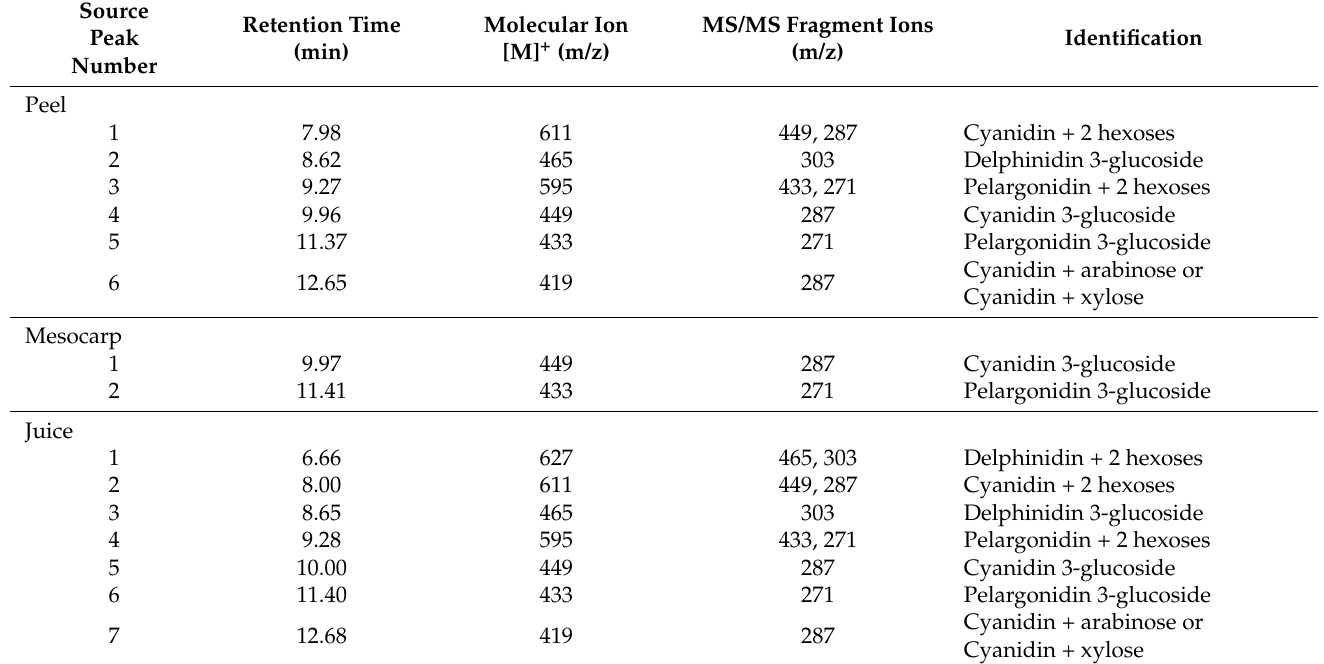
Table 6. Anthocyanin profiles of water and ethanol pomegranate